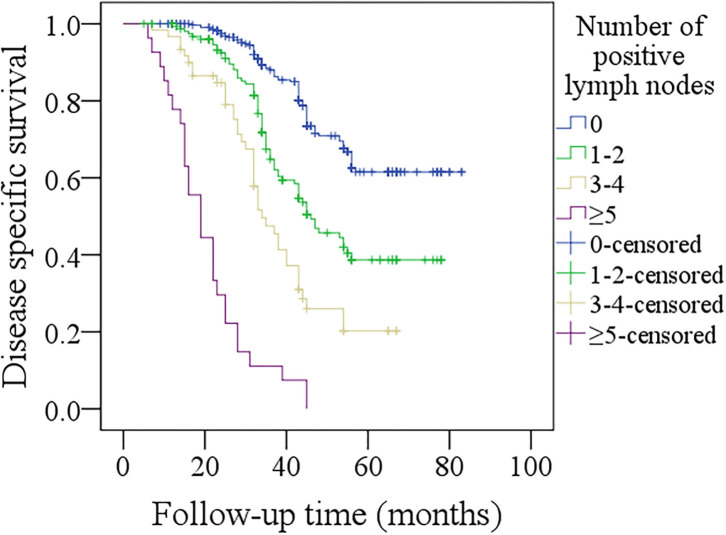
Comparison of disease-specific survival among p16 negative patients with different numbers of positive lymph nodes (p < 0.001).